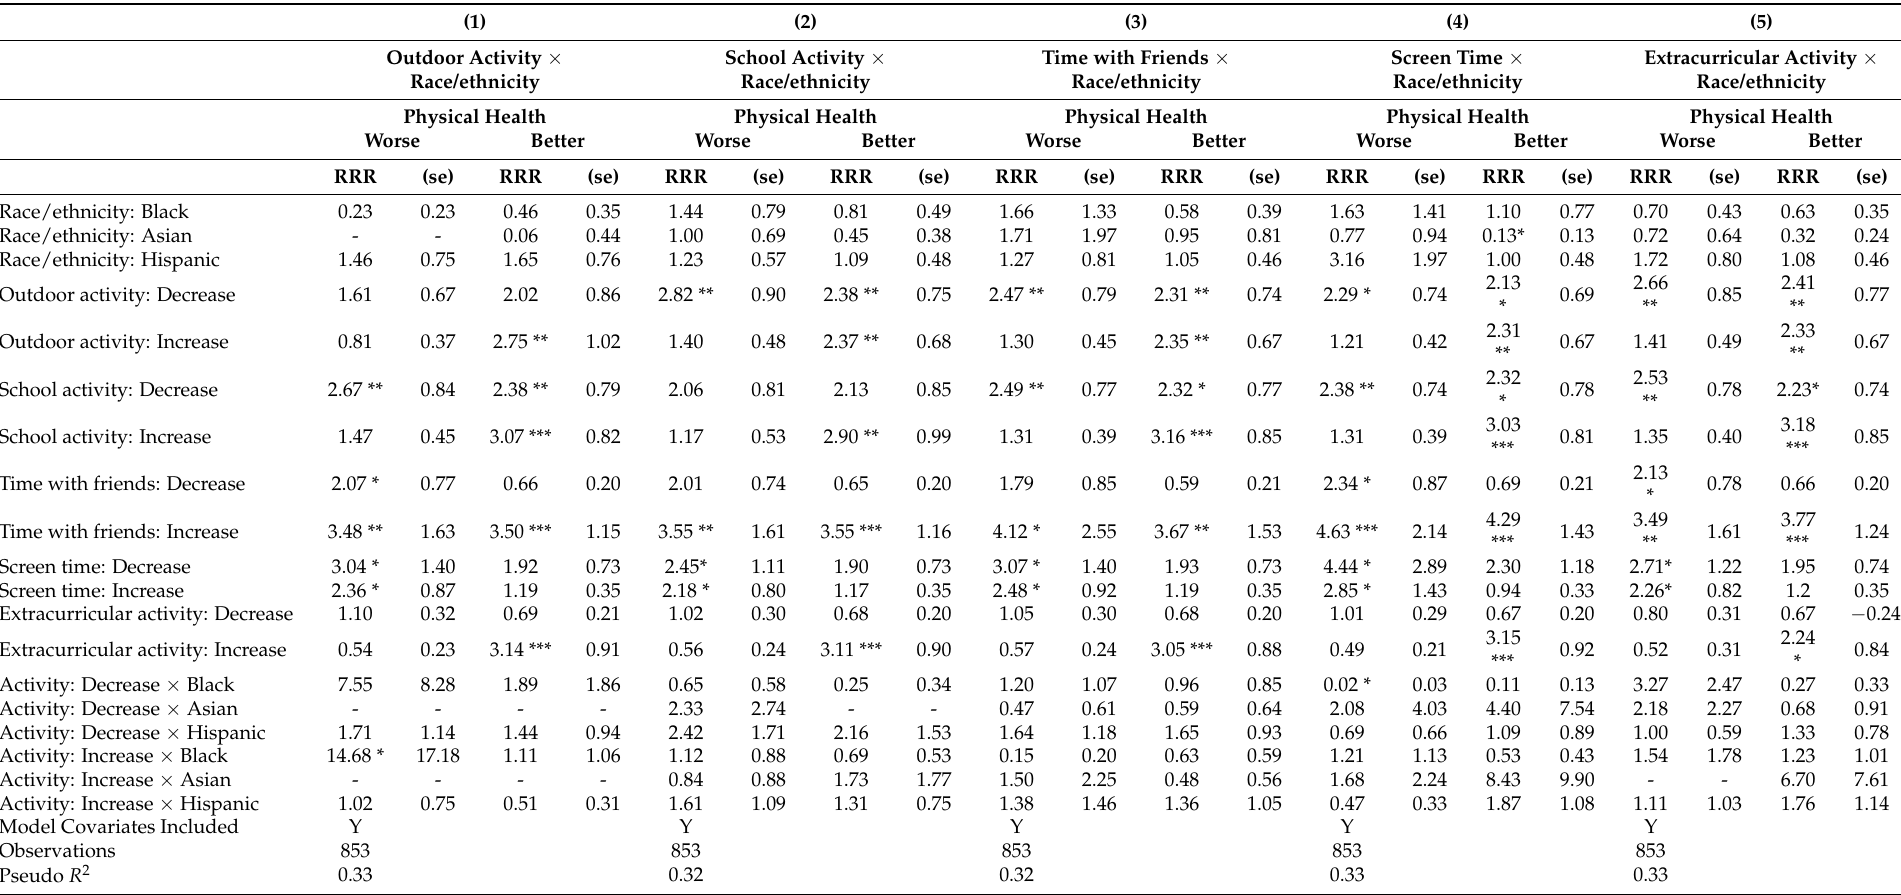
Table 3. Association of changes in child and adolescent activities with changes in physical health during COVID-19 with interactions by